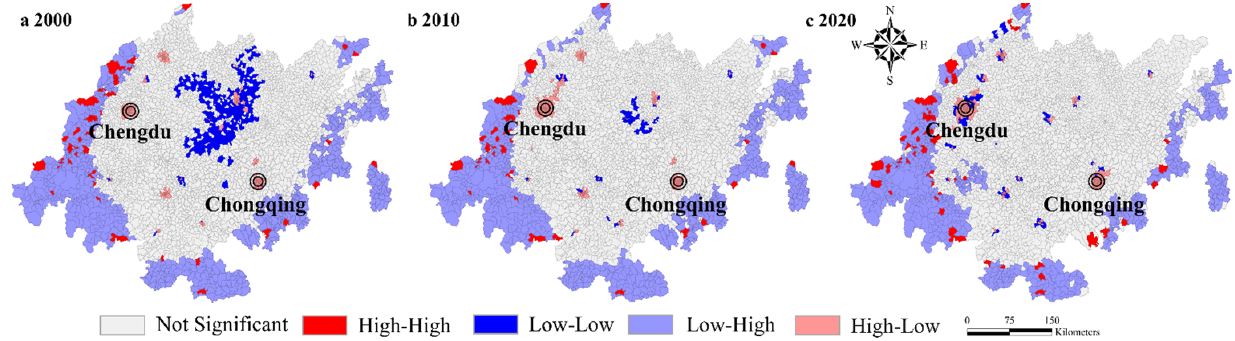
Figure 5. Bivariate spatially correlated clusters of UL and NPP in